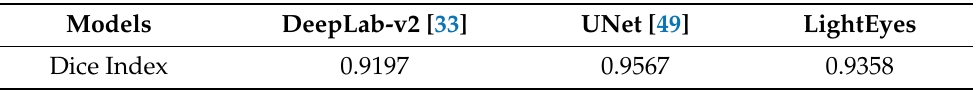
Table 17. The performance of the LightEyes and comparison with other methods on the Messidor